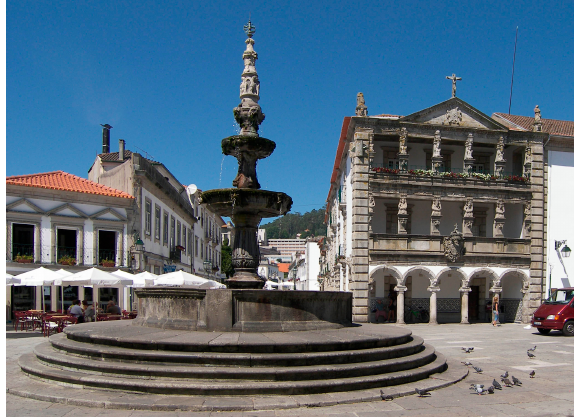
Figure 3. Fountain in the Republic Square, Viana do Castelo (Portugal), de Joao Lopes o Velho and Joao Lopes o Moço, 1545–1580. The photograph was provided by © ADSUBIA CC BY-SA 4.0, via Wikimedia Commons.